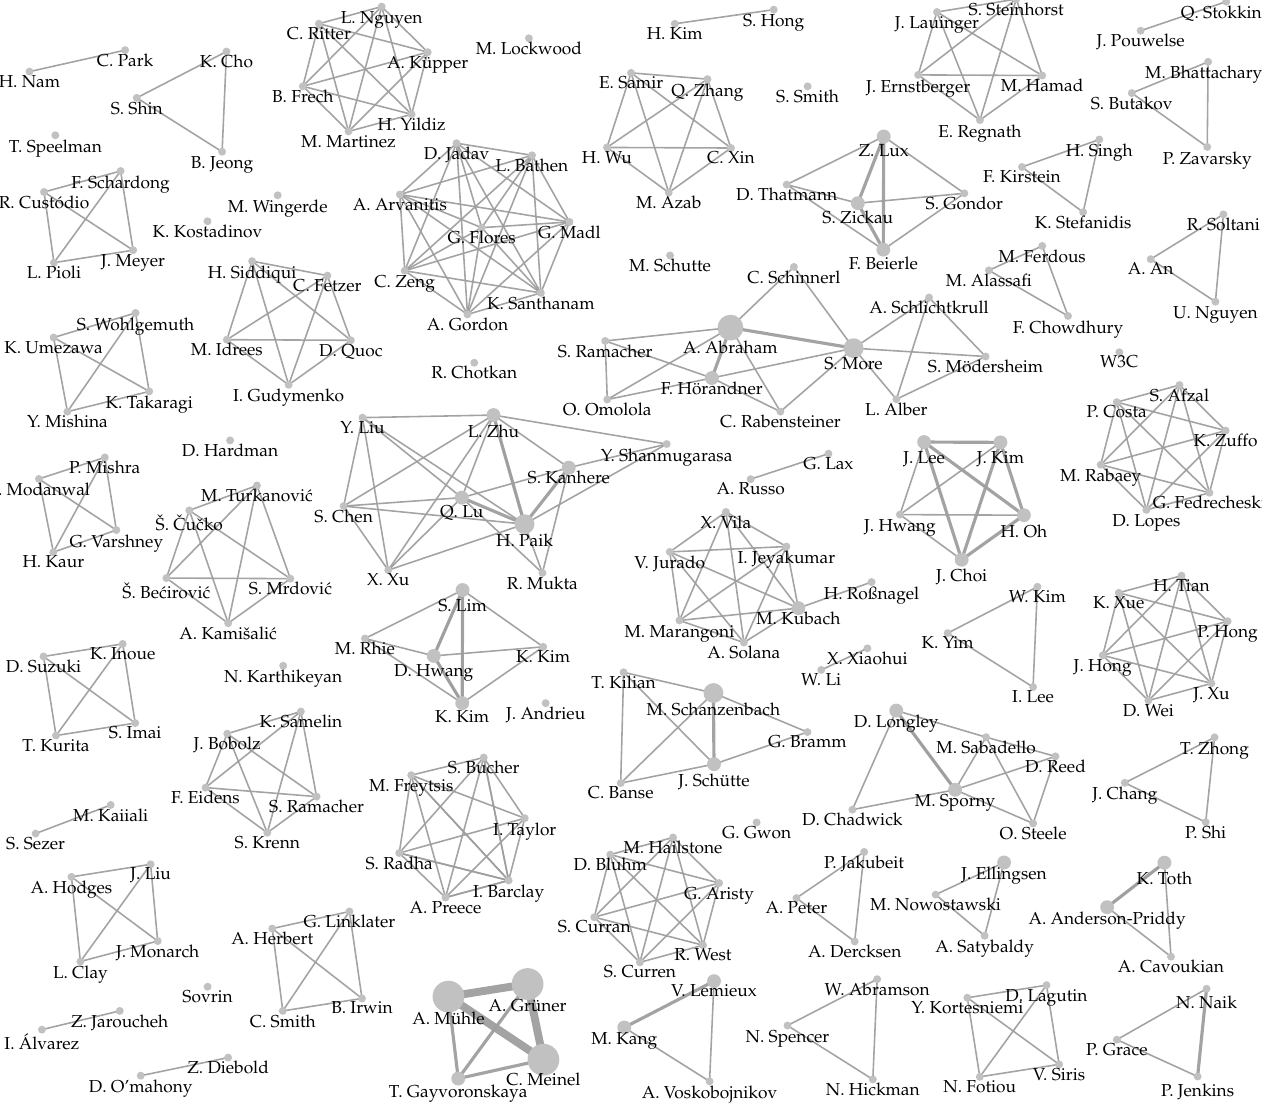
Figure 6. Co-authorship network graph, where vertices represent authors and edges their co- authorship of one or more